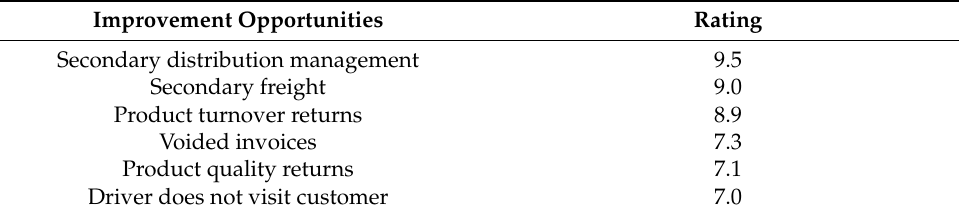
Table 9. Rating of improvement opportunities for secondary distribution.